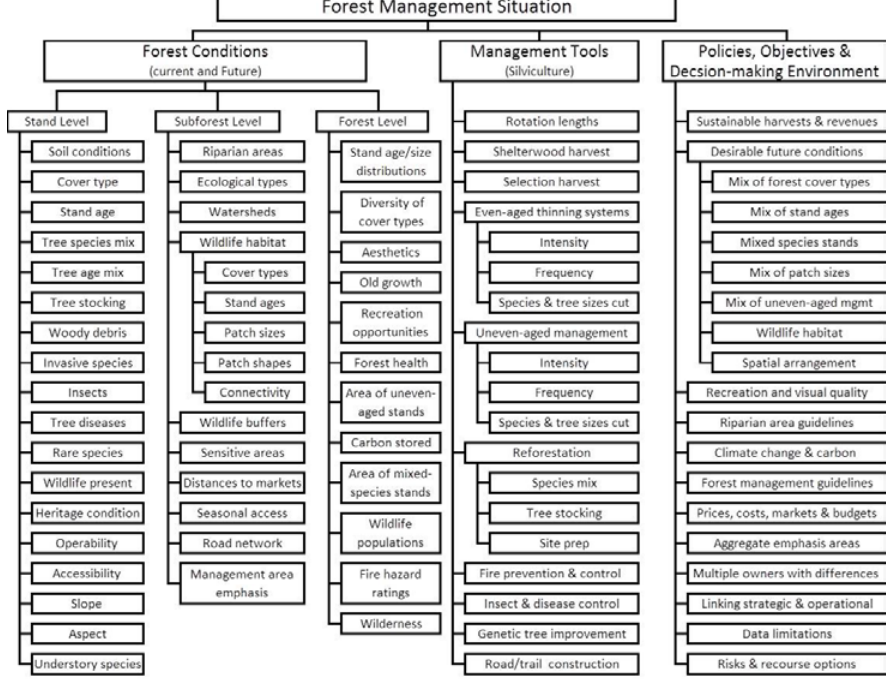
Figure 1. Potential facets of forest management situations (from Ref. [4]).